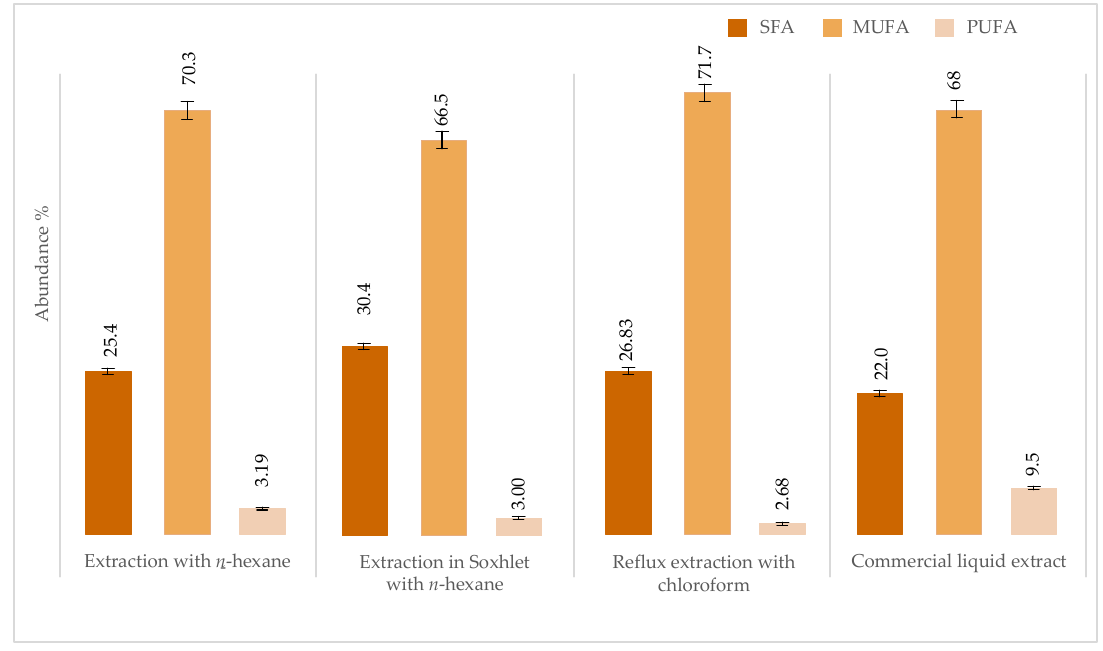
Figure 6. Graphical illustration of groups of fatty acids from the composition of spores of G. lucidum.